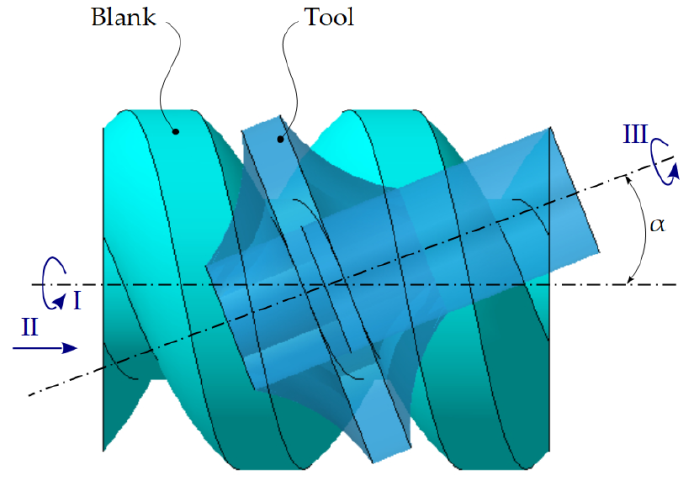
Figure 14. Axial section of the rotating surface.